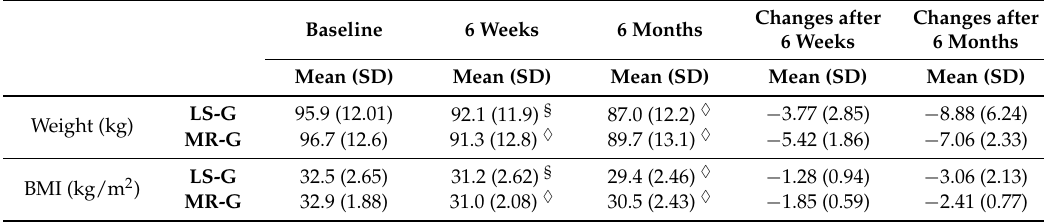
Table 1. Weight and BMI during the course of the study. Mean ˘ standard deviation (SD). LS-G, lifestyle intervention group; MR-G, meal replacement group. §, p < 0.05 compared to baseline; ♦ , p < 0.01 compared to baseline (paired T -Test). Differences between the intervention groups (ANOVA) were not significant at any point of the